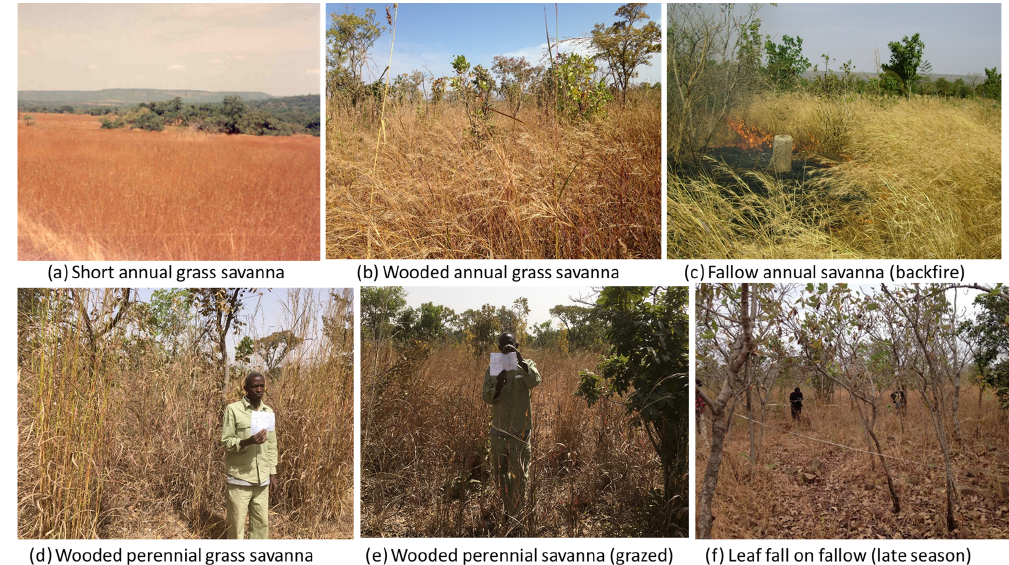
Figure 1. Different savanna vegetation types used in fire experiments for the study areas of Tabou and Faradiélé, Mali. Note that grass species, height and density, woody cover, and leaf litter amounts vary dramatically over space and time.